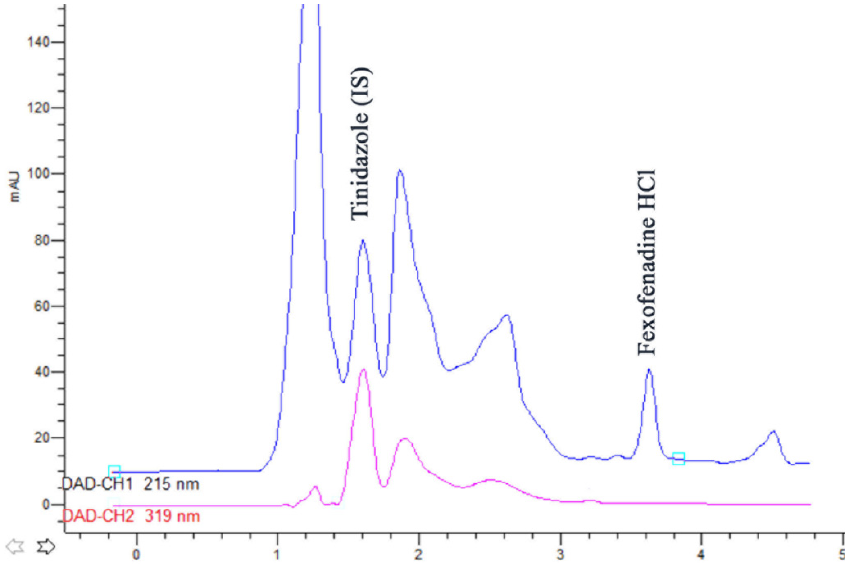
Figure 4. HPLC chromatogram for the analysis of rabbit plasma sample 1 h. after the administration of the optimized formulation loaded with FEX (3.61 min) showing the separation from Tinidazole (IS) and endogenous plasma compounds.